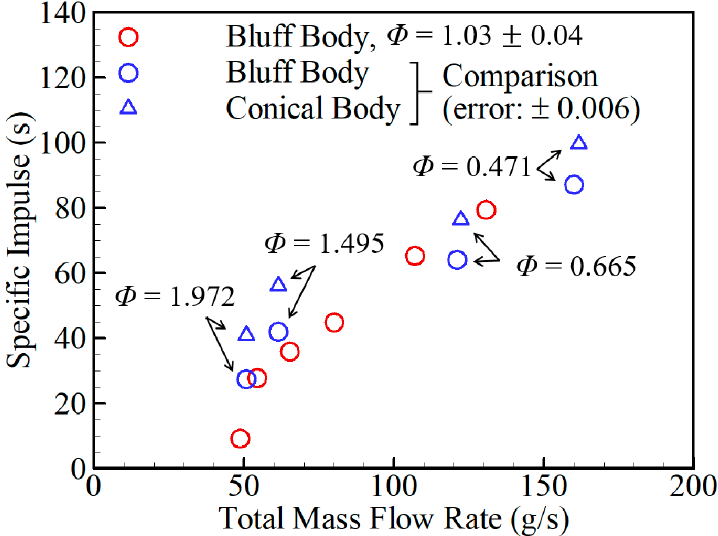
Figure 13. Specific impulse.